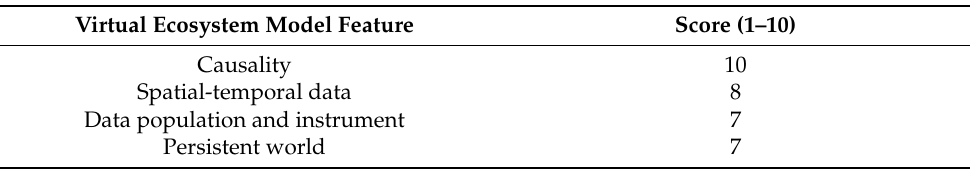
Table 4. Average of virtual ecosystem model evaluation on the Melting Sea Ice